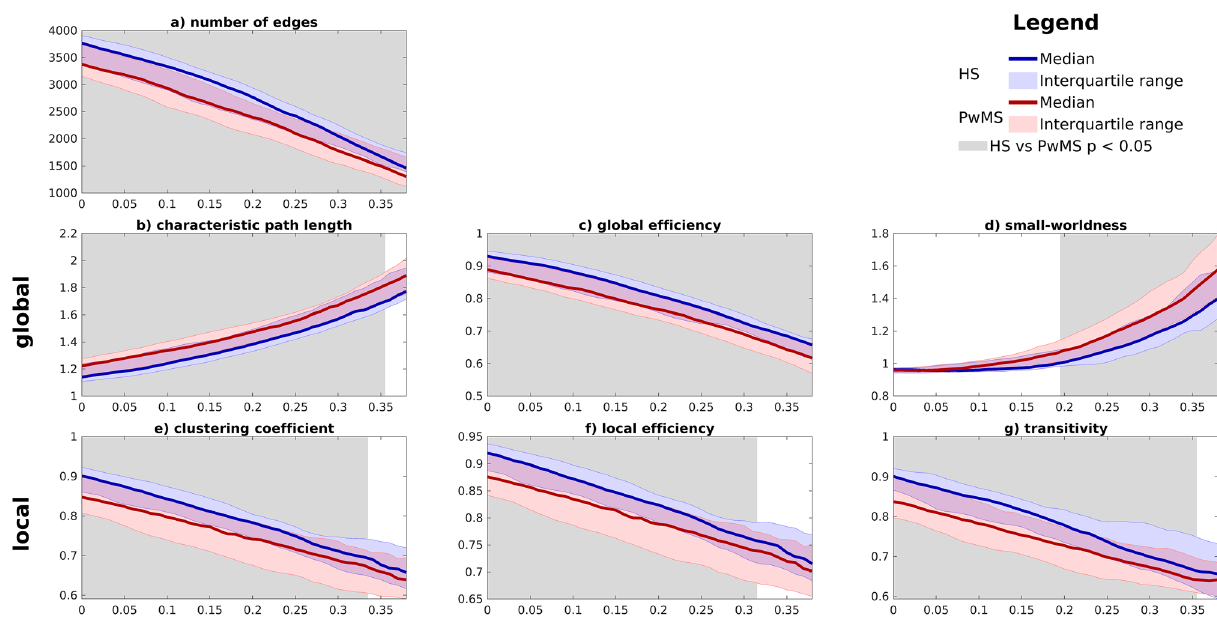
Figure 2. Graphs ( a ) to ( d ) show the global network parameters and ( e ) to ( g ) show the local network parameters. The median value and interquartile range of PwMS (red) and HS (blue) are presented. The x-axis represents the thresholds from the adjacency matrix from which networks were extracted. The background is shown in grey for the regions where the permutation test between the two groups showed a significant difference (p <